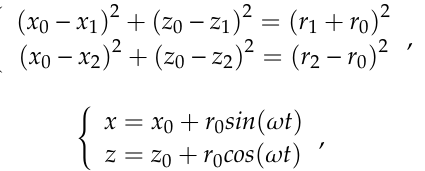
Figure 12. Spherical ellipse training trajectory.